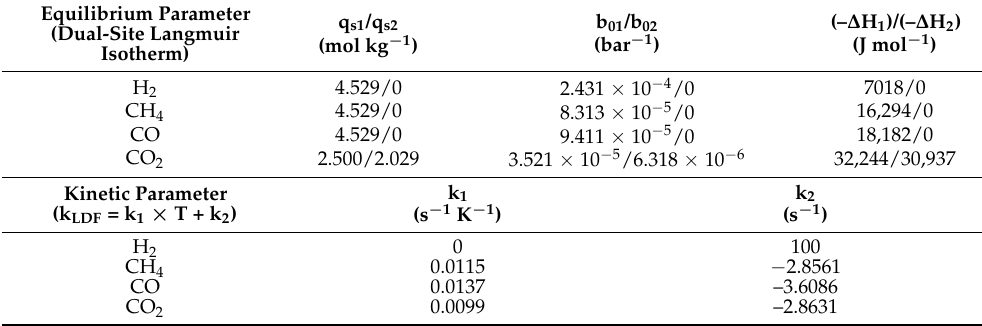
Table 1. Equilibrium and kinetic parameters for NaX zeolite. Data were regressed from [25]. Equilibrium Parameter (Dual-Site